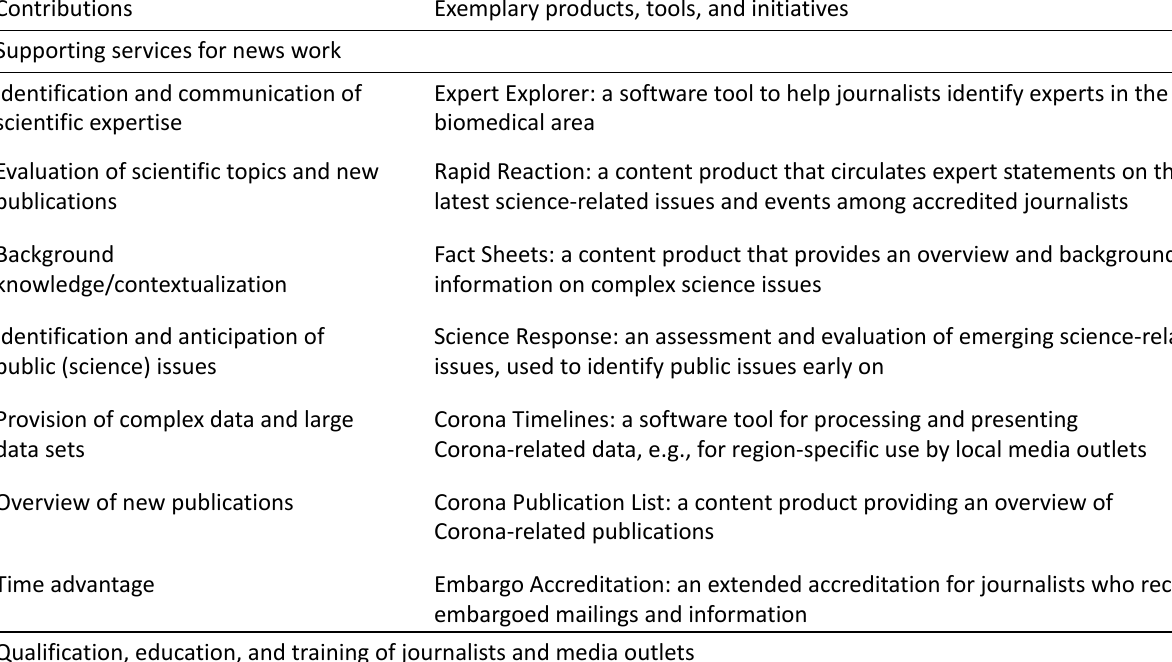
Table 2. Contributions of SMC to (science)